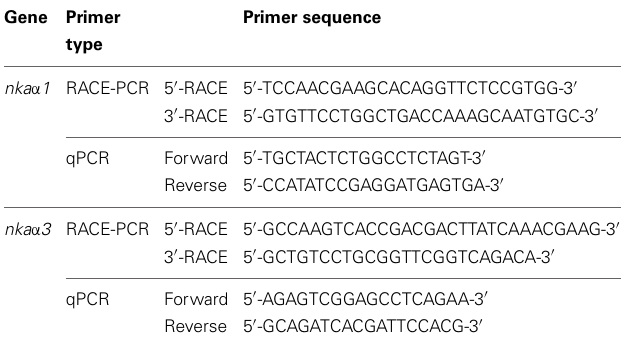
Table 1 | Primers used for RACE and quantitative real-time PCR (qPCR) of Na + /K + -ATPase (nka) α -subunit isoforms from gills of Periophthalmodon schlosseri